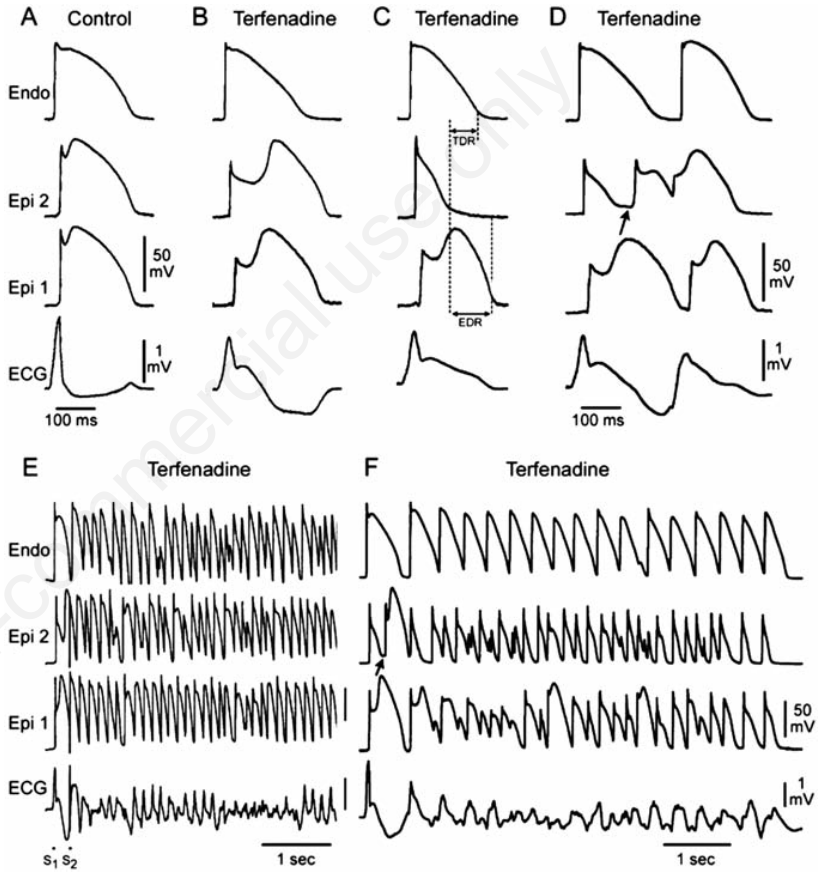
Figure 2. Cellular basis for electrocardiographic and arrhythmic manifestation of Brugada syndrome. Each panel shows transmembrane action potentials from one endocardial (top) and two epicardial sites together with a transmural electrocardiogram (ECG) recorded from a canine coronary-perfused right ventricular wedge preparation. A) Control [basic cycle length (BCL) 400 ms]. B) Combined sodium and calcium channel block with terfenadine (5 µM) accentuates the epicardial action potential notch creating a transmural voltage gra- dient that manifests as an exaggerated J wave or ST segment elevation in the ECG. C) Continued exposure to terfenadine results in all-or-none repolarization at the end of